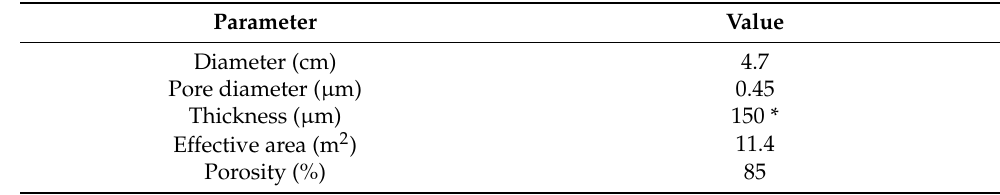
Table 1. Characteristics of the microporous polytetrafluoroethylene film (Fluoropore™ FHLP04700).